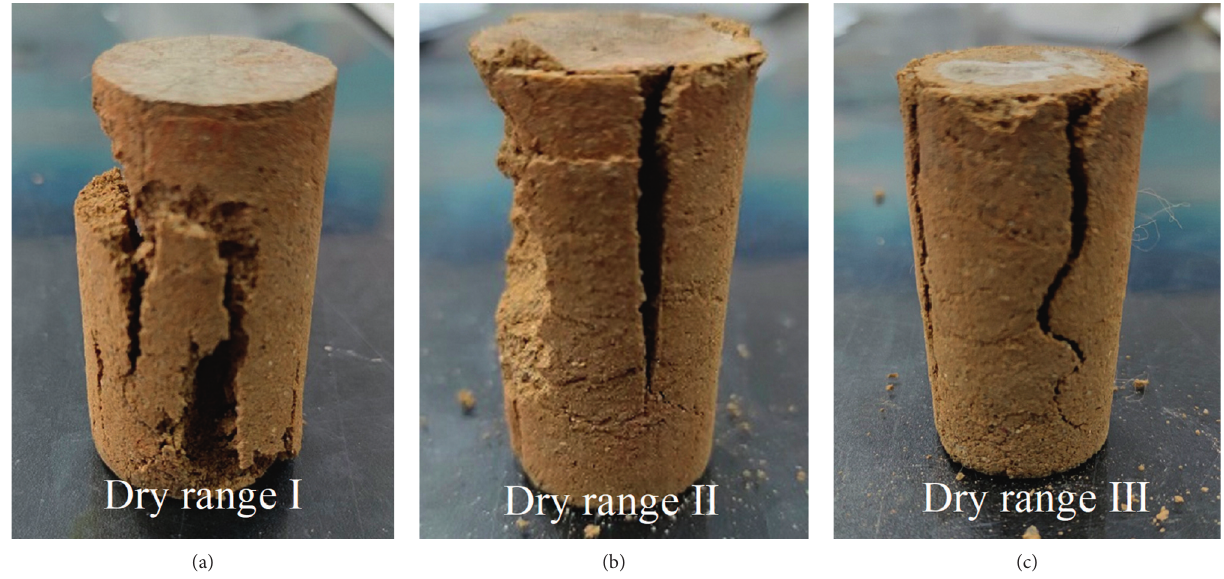
Figure 9: Typical failure characteristics of samples subjected to WDFT cycles.